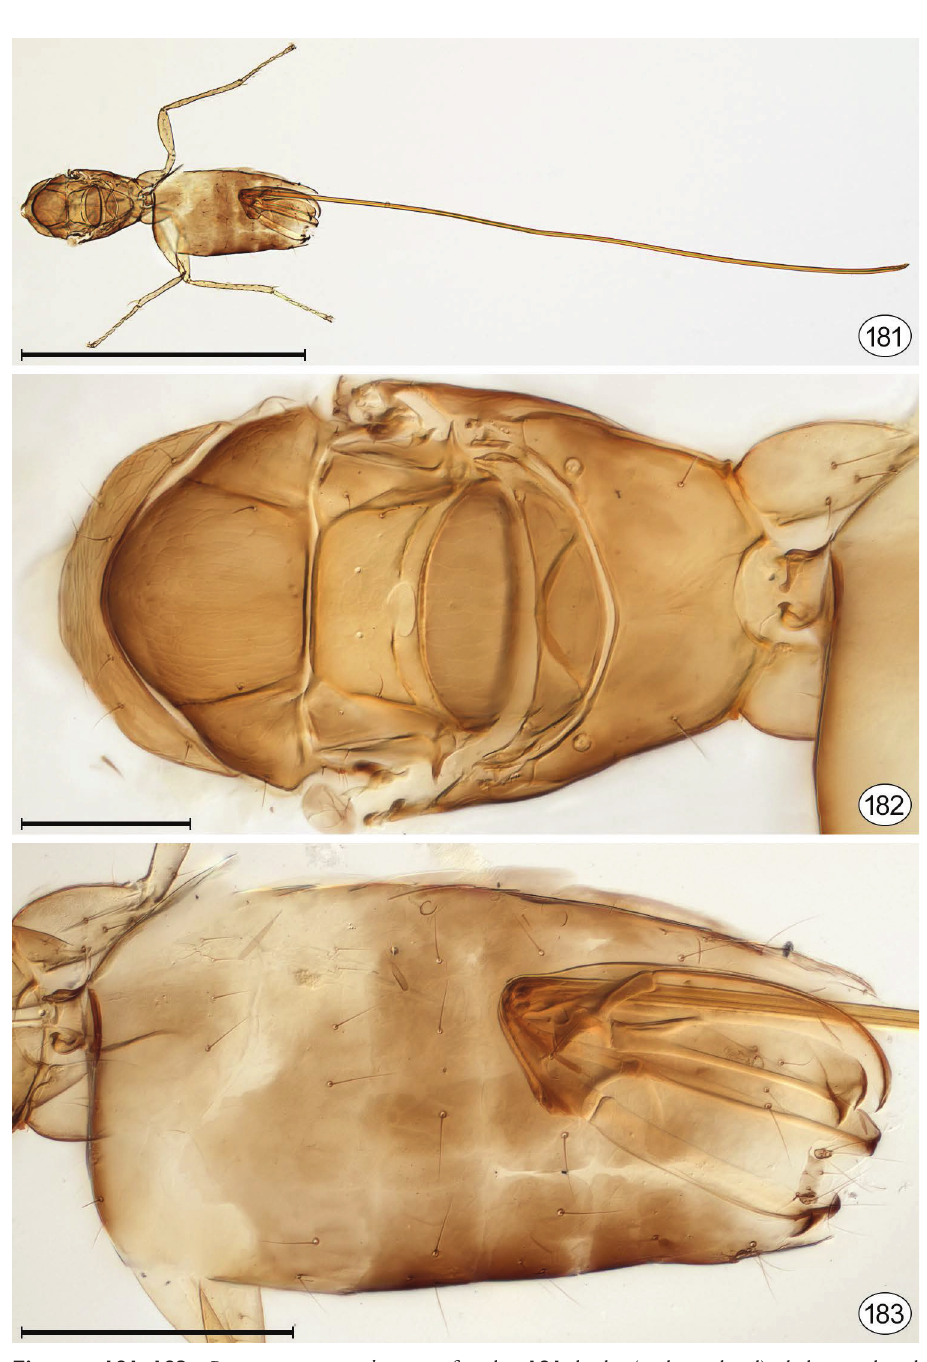
Figures 181–183. Borneomymar madagascar , female. 181 body (without head), habitus, dorsal 182 mesosoma, dorsal 183 metasoma, dorsal (slightly twisted). Scale bar for 181 = 1000 μm; 182, 183 = 100